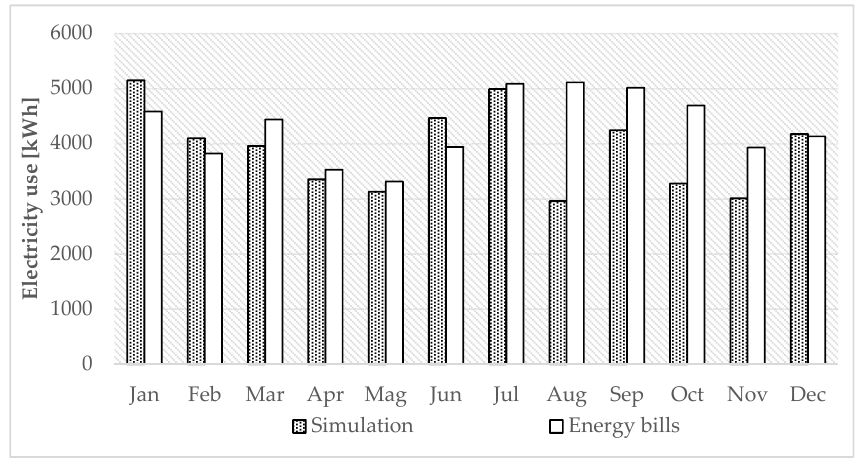
Figure 10. Validation of the simulation, monthly data.